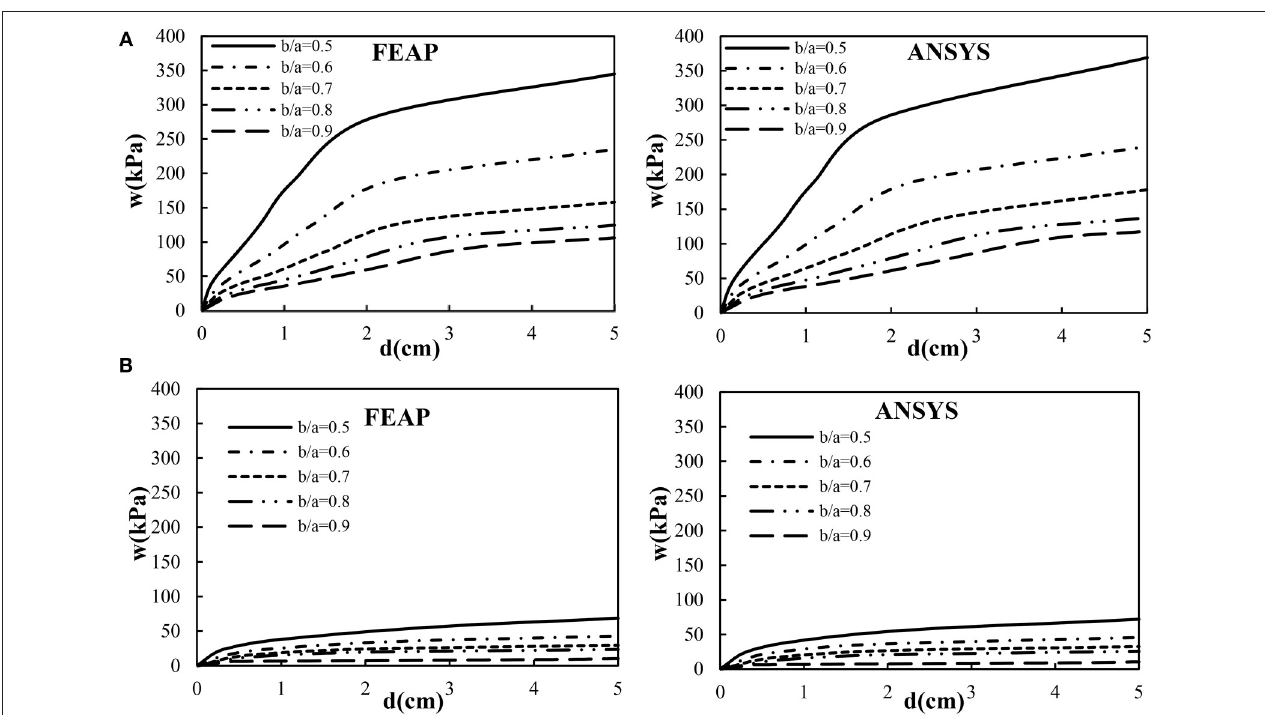
FIGURE 11 | Load vs. displacement curves at the midspan of elliptic slab: (A) clamped and (B) simple supported.